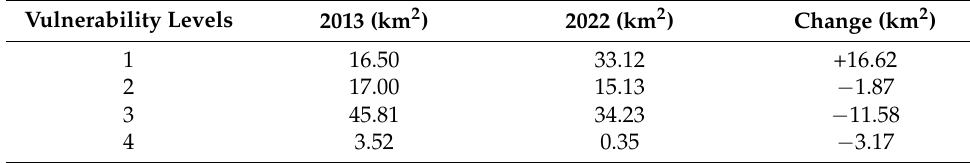
Table 6. Results of tsunami vulnerability